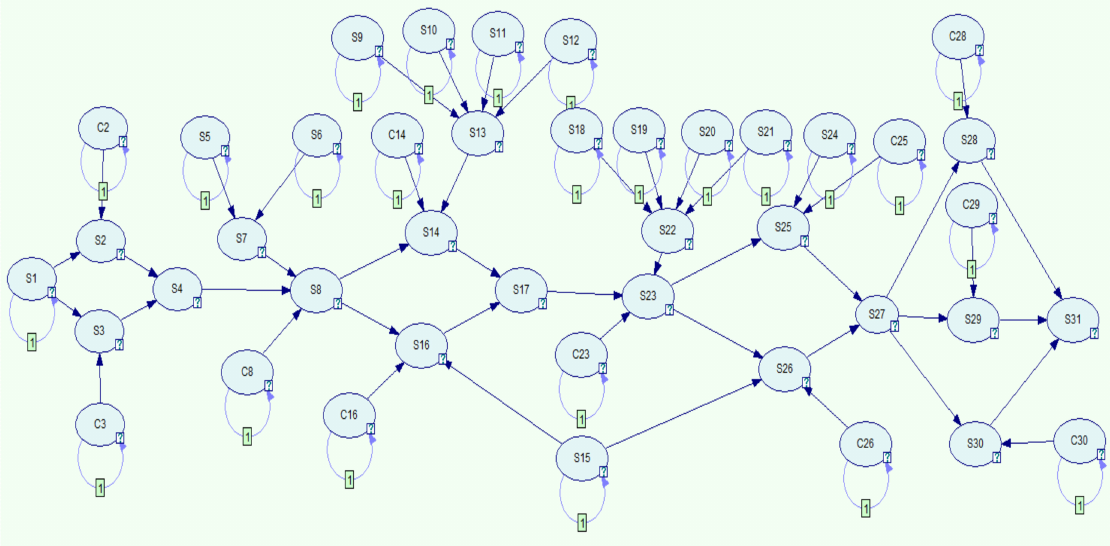
Figure 12. Dynamic Bayesian network diagram of the smart